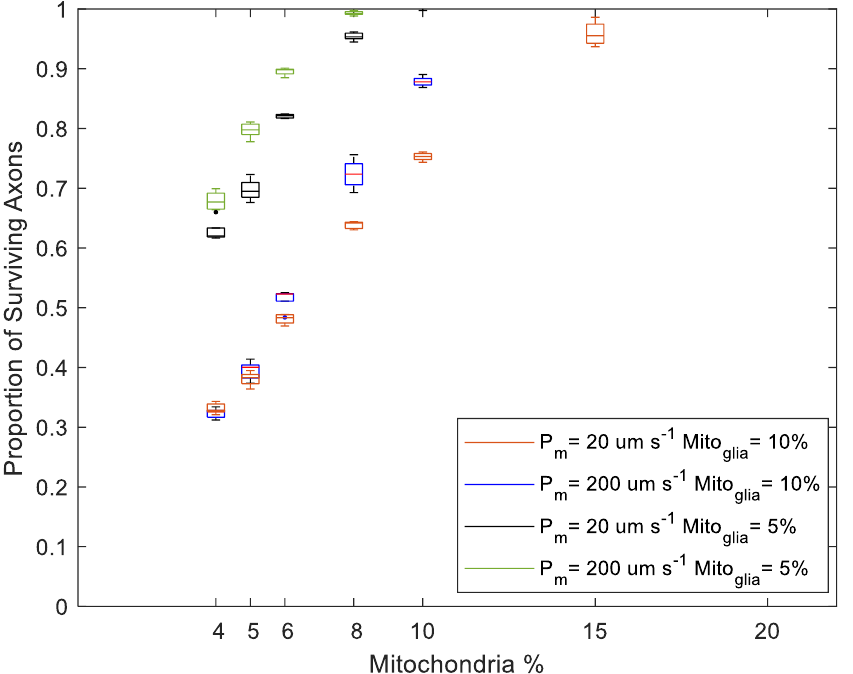
Figure 13. Proportion of axonal survival when axons and glia interact via H 2 O 2 increased as the mito% increased. Axonal mitochondria operated in NF RP mode while glia mitochondria were in PF RP mode. Two membrane permeability settings were used (P m = 20 µm s −1 and P m = 200 µm s −1 ), as well as two settings for the glial mitochondrial content (5% and 10%) for a total of 4 data sets. For each pair of settings P m and Mito glia , mito% was varied between 4 and 20%.